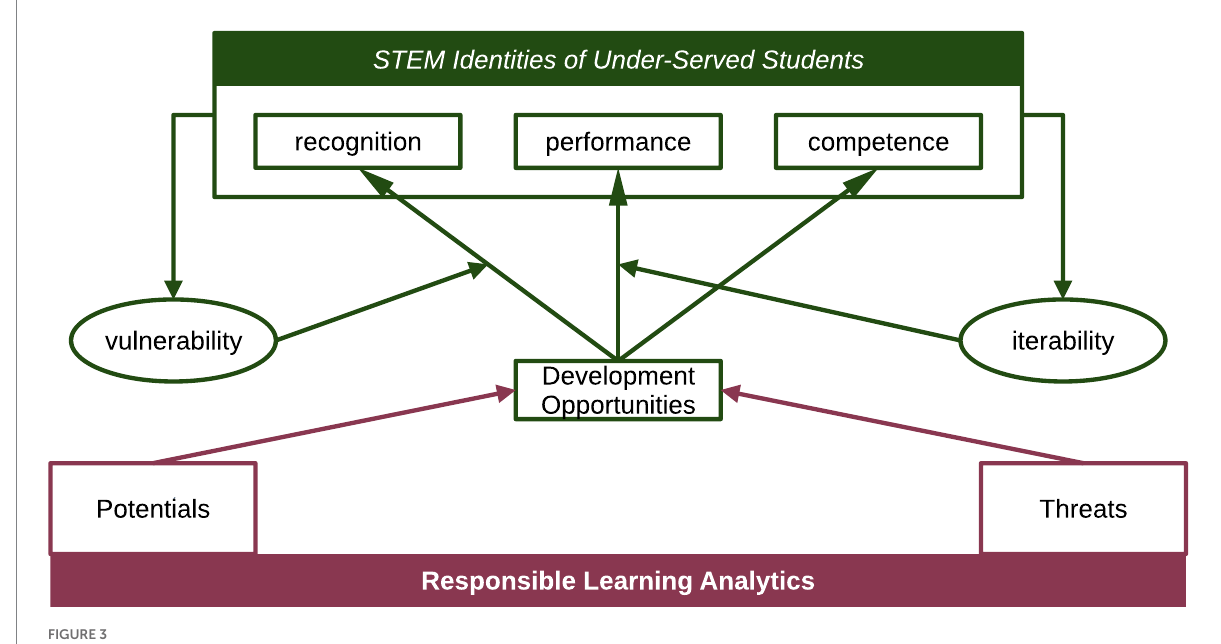
FIGURE 3 Responsible learning analytics in the context of STEM identities of under-served